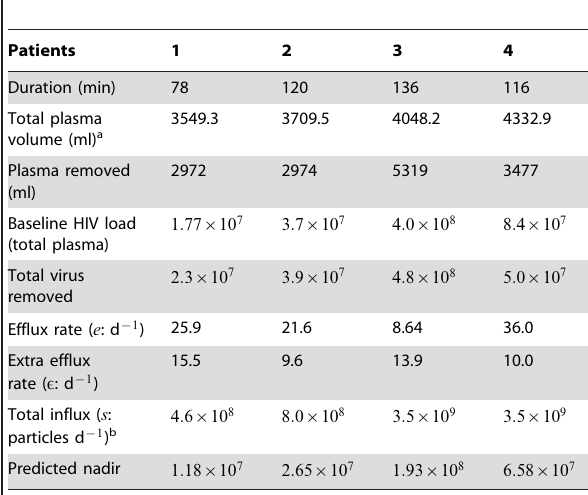
Table 2. The plasma apheresis data from Ramratnam et al.